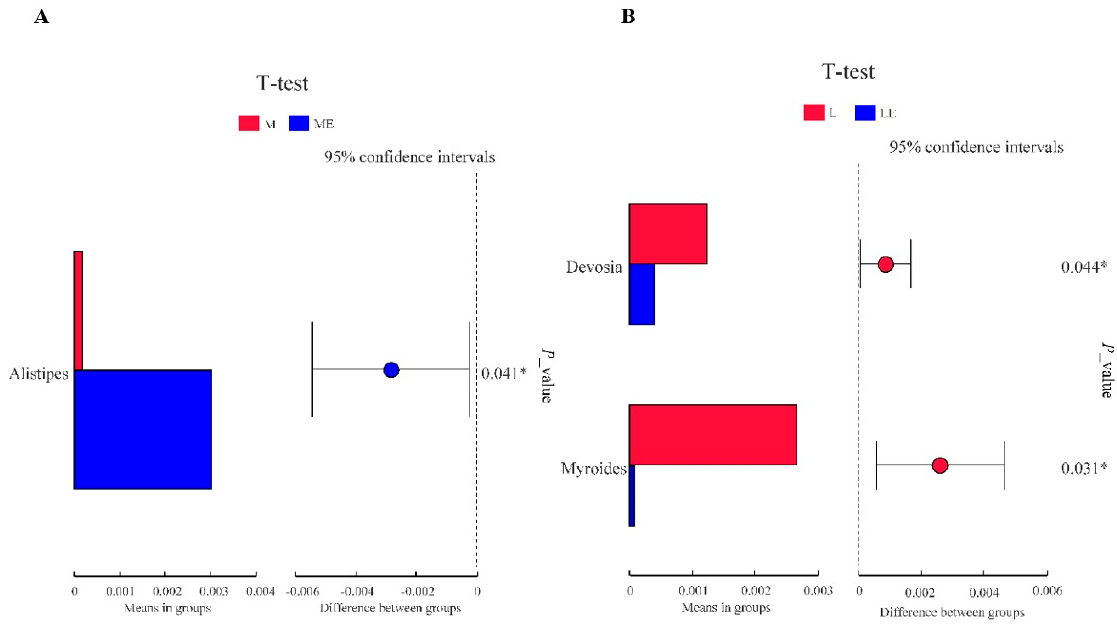
Figure 5. Importance T − test for functional variance analysis (Figure5 A= groups M and ME by T − test; Figure5 B = groups L and LE by T − test). “*” indicated significant difference at the p < 0.05